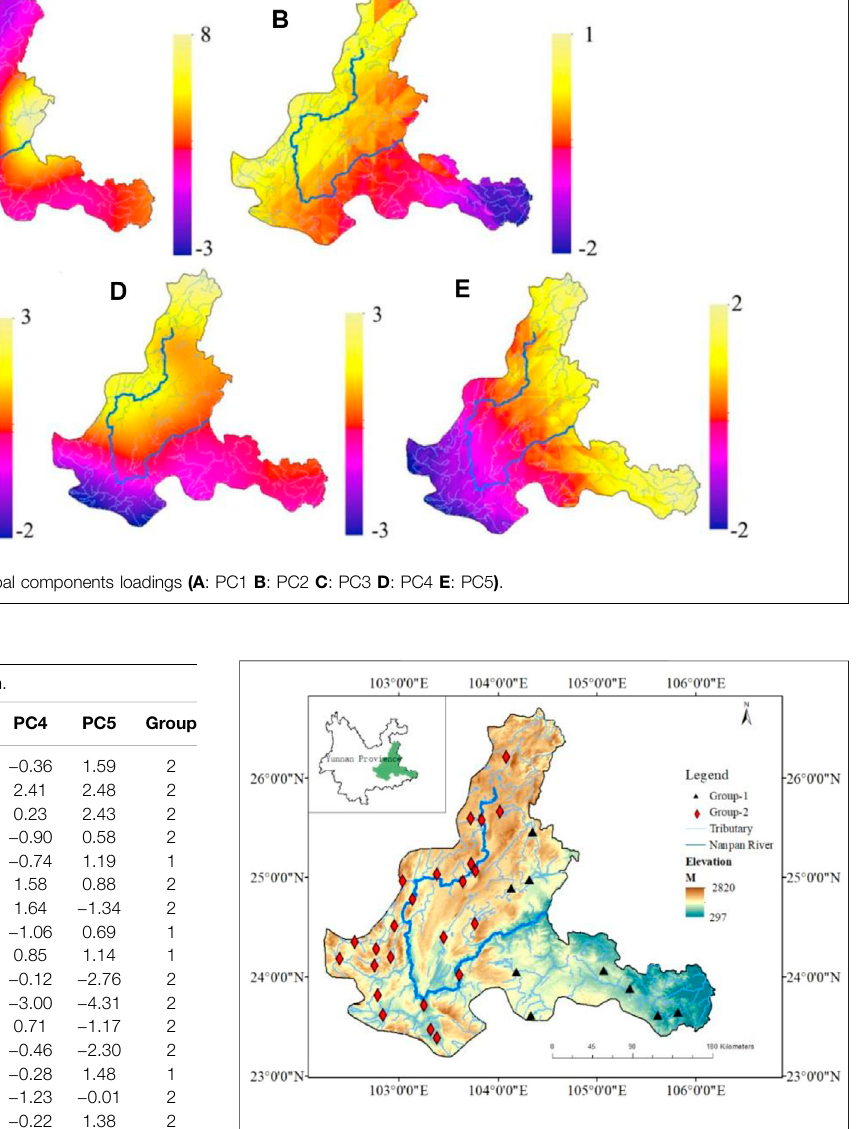
FIGURE 5 | Identi fi ed the homogenous precipitation